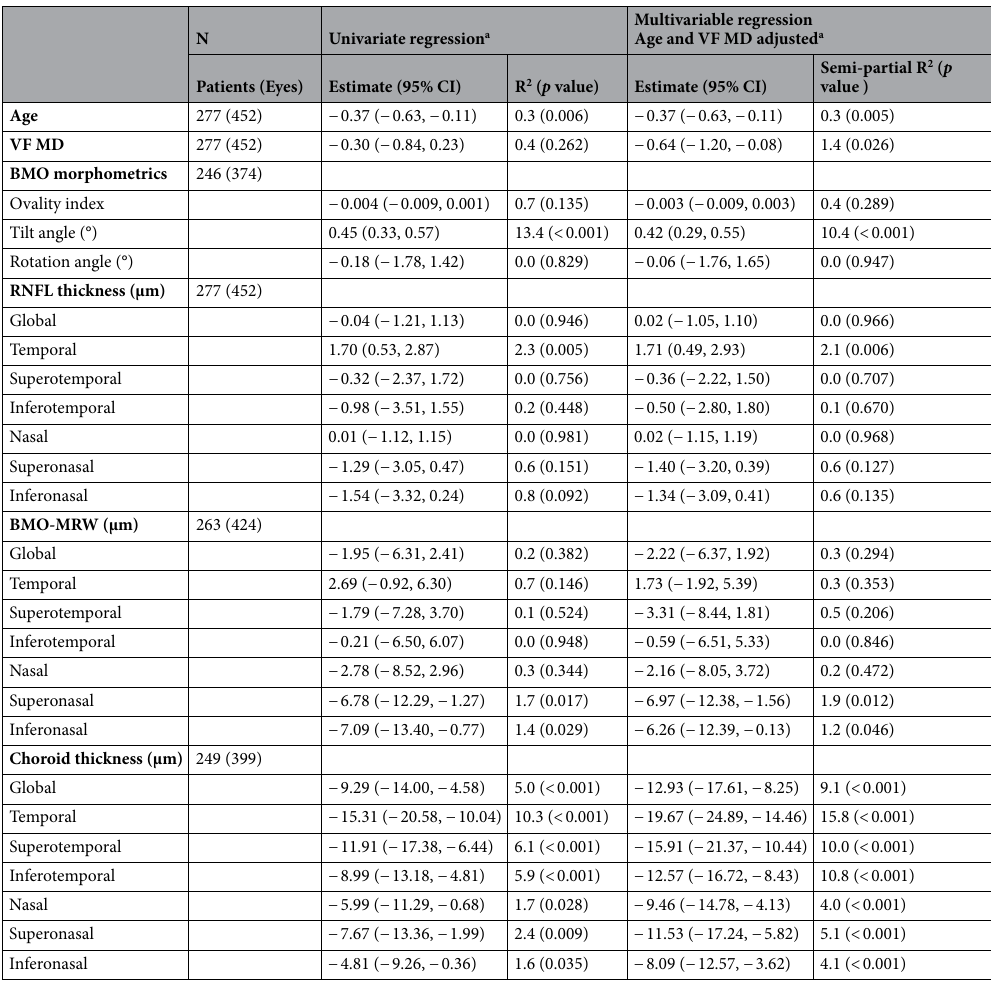
Table 3. The association of ocular characteristics with axial length. BMO-MRW, Bruch’s membrane opening minimum rim width; CI, confidence interval; ONH, optic nerve head; RNFL, retinal nerve fiber layer; VF MD, visual field mean deviation. a Linear mixed models slope estimates (with 95% confidence intervals) from univariate and multivariable models adjusted for age and VF